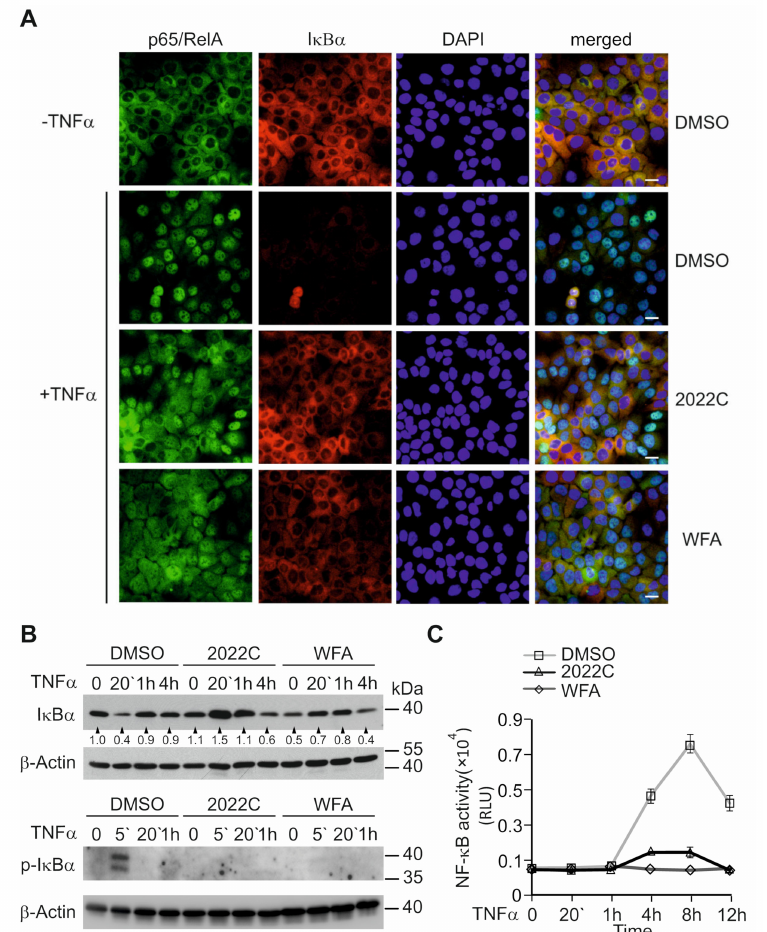
Figure 3. Effects of NAE_2022C on I κ B α degradation and the nuclear translocation of NF- κ B in TNF α - stimulated HaCaT cells. ( A ) NAE_2022C inhibits the nuclear accumulation of p65/RelA in response to TNF α . Cells were either left untreated or stimulated with 10 ng mL − 1 TNF α for 20 min in the presence of 0.1% DMSO, 750 nM WFA, or 10 µ g mL − 1 NAE_2022C. The p65/RelA (green) and I κ B α (red) proteins were visualized by indirect immunofluorescence. Hoechst (blue) was used to localize nuclei. Scale bar, 10 µ m. ( B ) The effects of WFA and NAE_2022C on the degradation and re-synthesis of I κ B α in response to TNF α . NF- κ B-reporter HaCaT cells were incubated with DMSO, WFA or NAE_2022C, as described in ( A ), and then treated with 0.75 ng mL − 1 TNF α for the indicated times. Whole-cell lysates were analyzed by immunoblotting using I κ B α , phospho-I κ B α and β -Actin-specific antibodies. The intensity of the bands was quantified using Image J normalized to β -Actin, and denoted as the fold change relative to the control. ( C ) NF- κ B responses were evaluated in cell lysates from ( B ) by measuring luciferase activity. Values are means ± SD of at least three